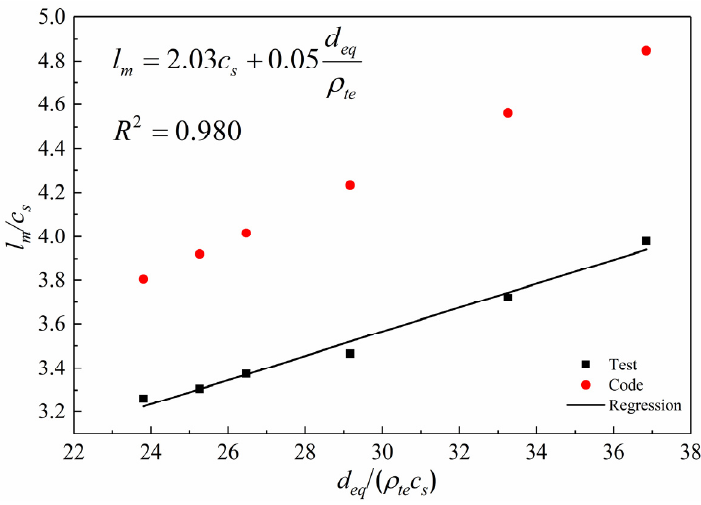
Figure 12. Regression of average crack interval.